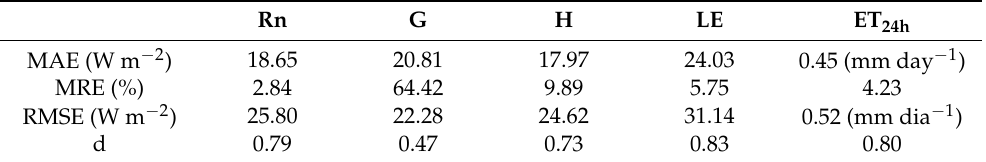
Table 3. The average absolute error, average relative error, root of the average quadratic error, and concordance index between the energy balance and evapotranspiration variables.